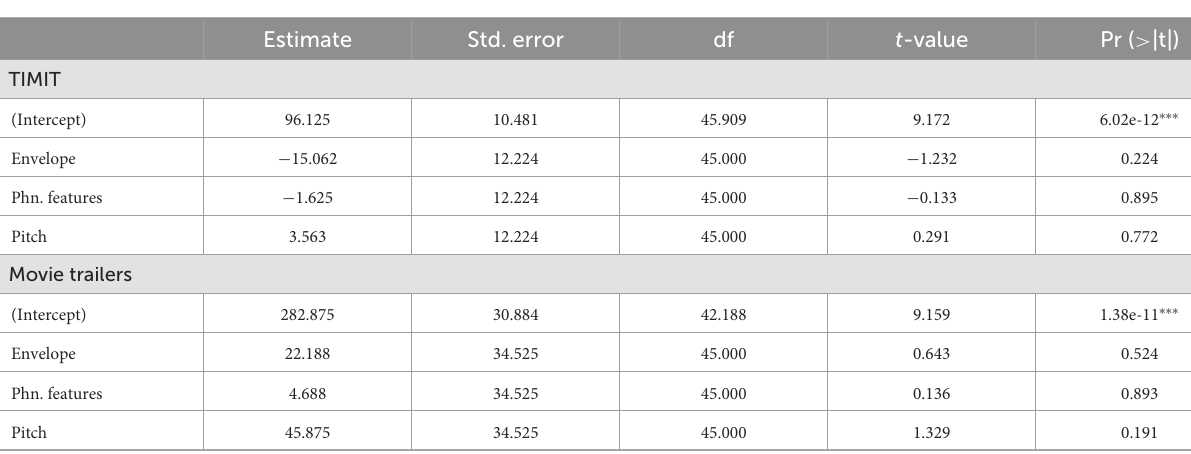
TABLE 1 Fixed effects for each stimulus from